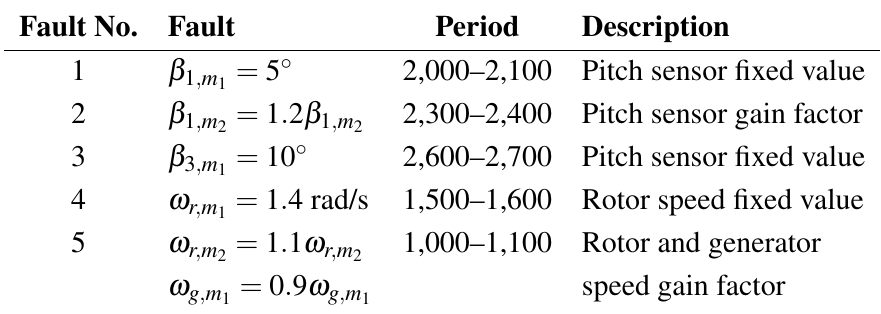
Table 1. List of sensor faults.